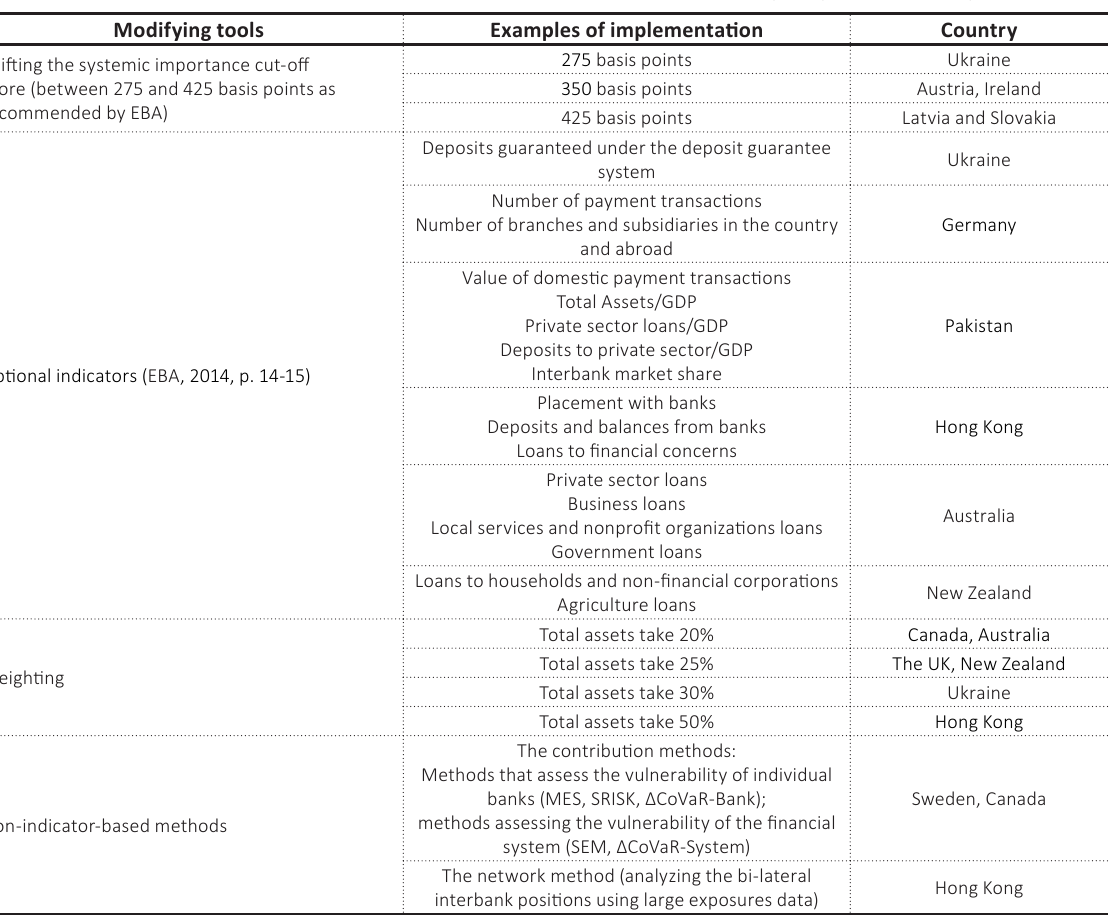
Table 1. Modifying tools in an assessment methodology for identifying